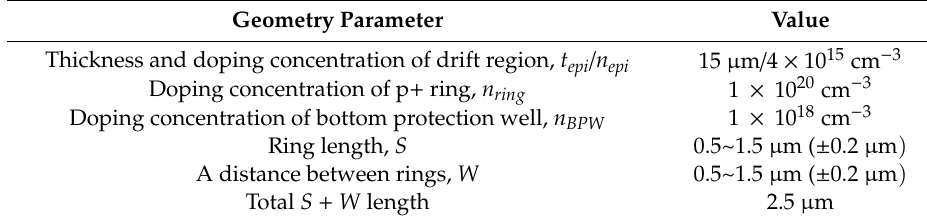
Table 1. Geometry parameters and conditions for the edge-termination structures used in the